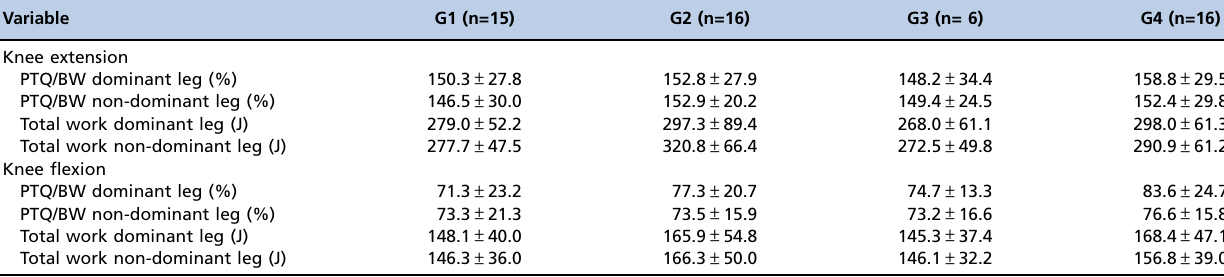
Table 3 - Isokinetic performance of the study participants in each group (G).